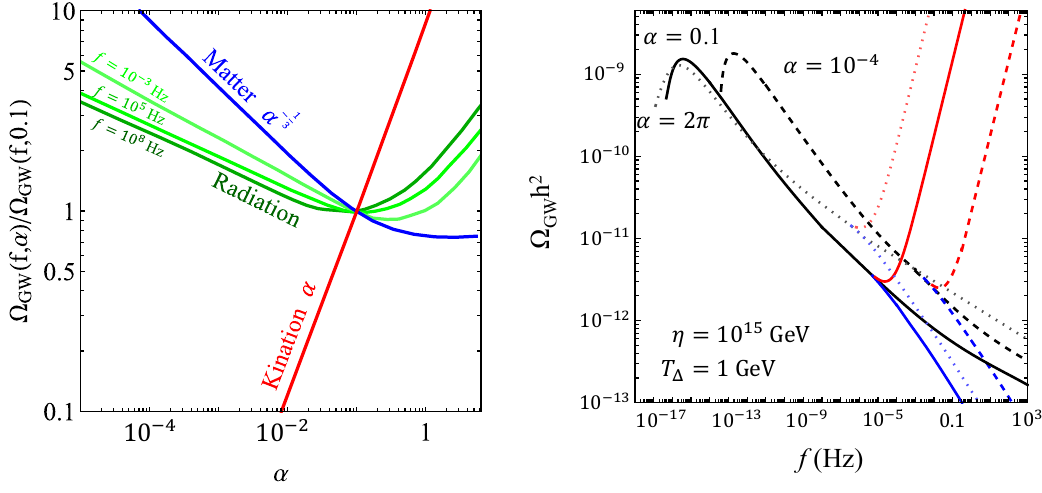
Figure 12 . Left panel: Ω GW ( f, α ) normalized by the prediction with α = 0 . 1 , varying α in the range of 10 − 5 ≤ α ≤ 10 , η = 10 15 GeV for different background cosmologies (for MD and kination, the departure from standard cosmology is assumed to occur at T = 1 GeV). The green lines show ∆ the results with radiation dominated epoch with varying f = 10 − 2 , 10 − 5 , 10 − 8 Hz, and the red (blue) line shows the results for kination (matter) domination which are insensitive to f . Right panel: GW frequency spectra with varying loop size α (dotted: α = 2 π , solid: α = 0 . 1 , dashed: α = 10 − 4 ) with various background cosmologies: standard cosmology (black), kination (red) and EMD (blue)–another way of illustration with the same choices of η , T as in the left panel. ∆